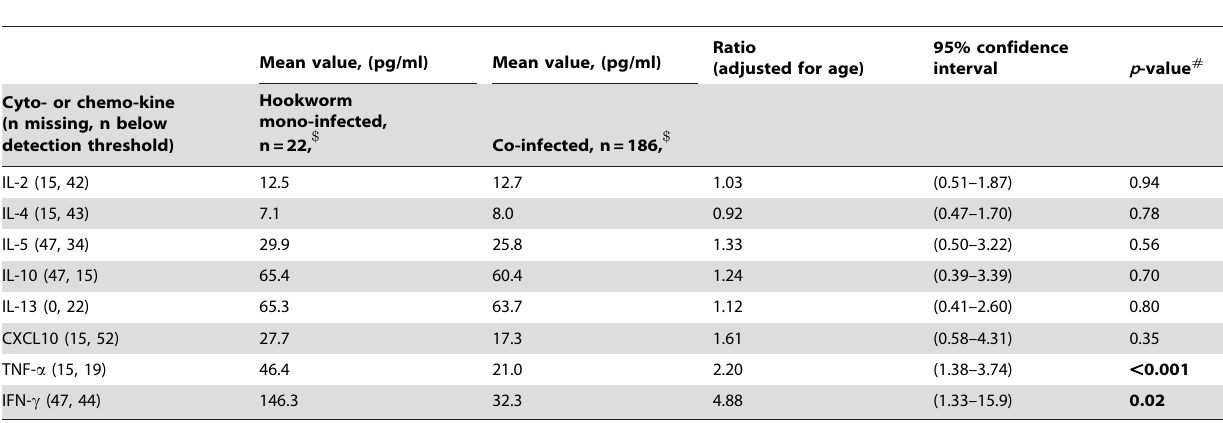
Table 6. Adult worm antigen-induced cytokine and chemokine secretion in lymphocyte cultures from individuals mono- or co-infected with